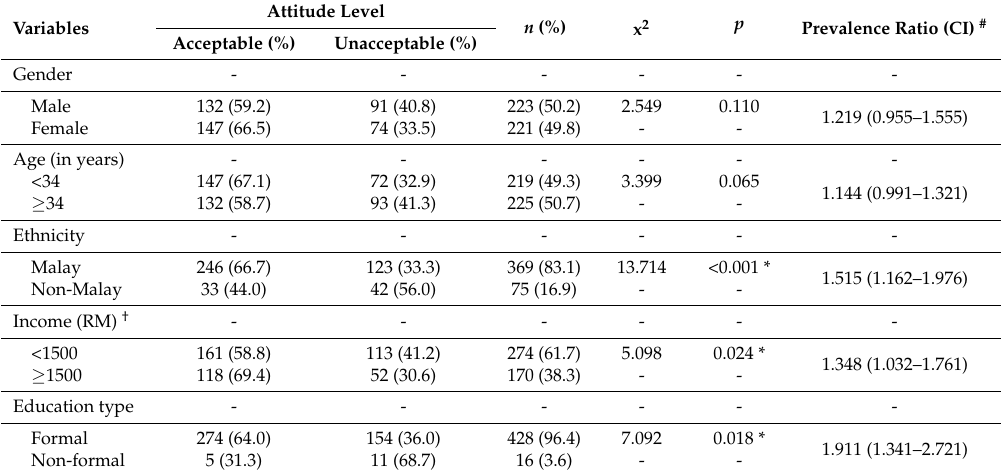
Table 4. Level of attitude among rural communities in relation to socio-demographic